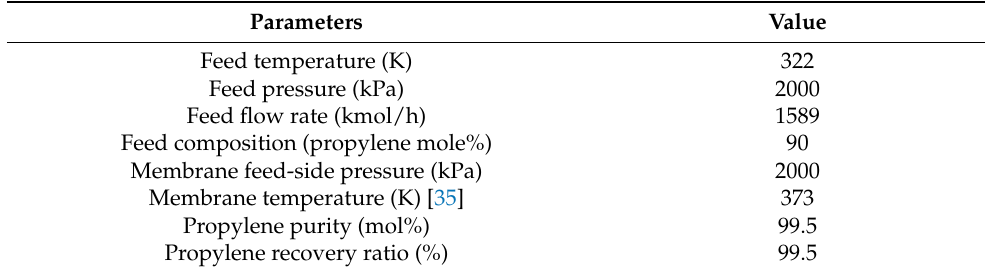
Table 2. Feed conditions and product requirements of the membrane-separation process used in this study.